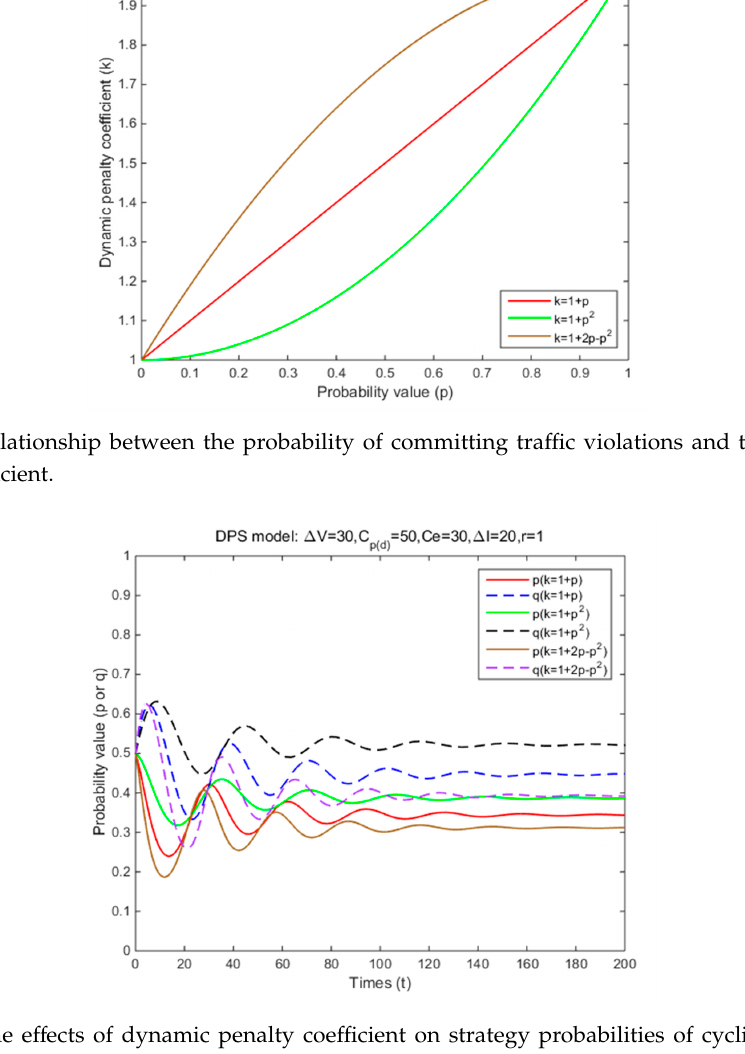
Figure 2. The effects of enforcement effectiveness on strategy probabilities of cyclists and law Figure 2. The e ff ects of enforcement e ff ectiveness on strategy probabilities of cyclists and law enforcement under DPS (Situation 3). enforcement under DPS (Situation 3). Int. J. Environ. Res. Public Health 2020 , 17 , x